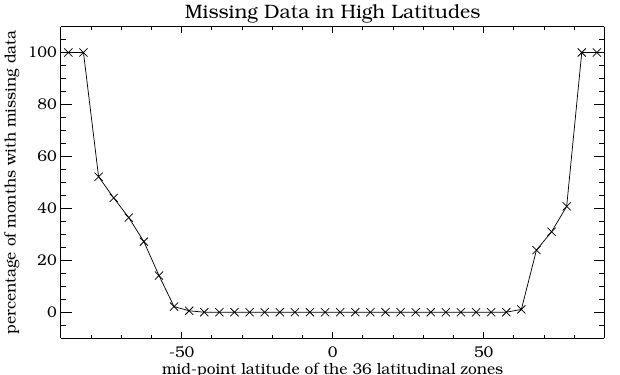
Figure 2. Missing data in high latitudes for SBUV v8.6.